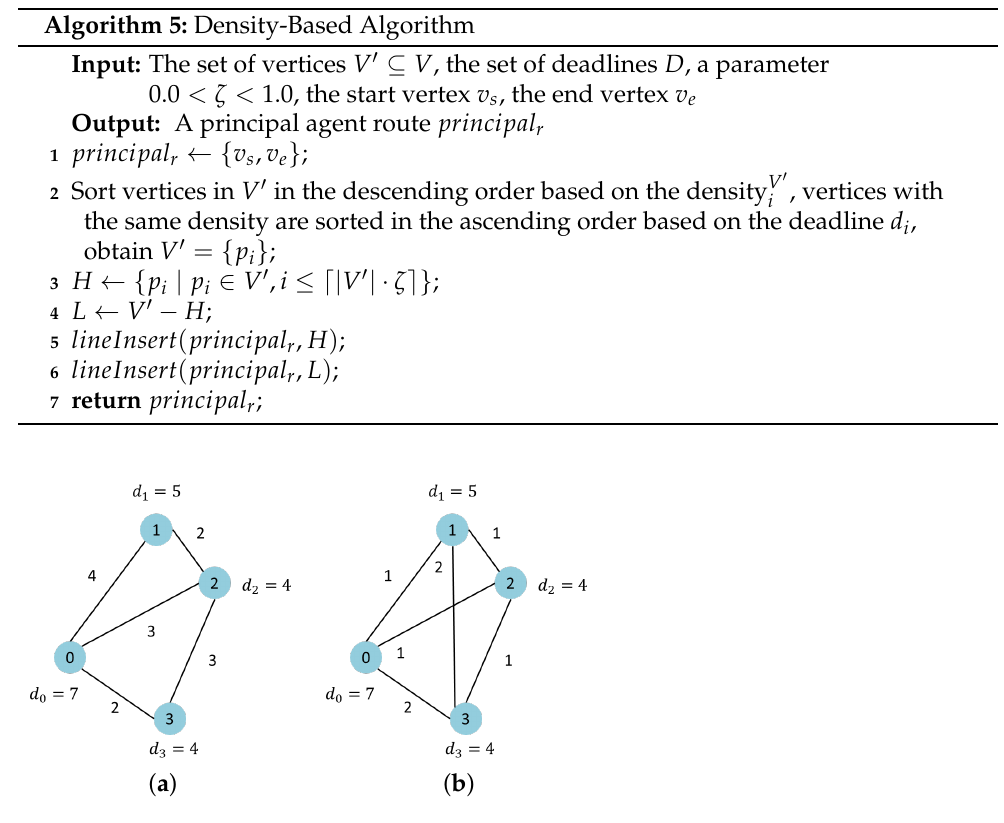
Figure 3. The influence of the density: Subfigure ( a ) shows the tasks V in graph G 1 and Subfigure ( b ) shows the tasks V in graph G 2 . The principal–assistant team has 1 principal agent and 2 assistant agents, the duration of which is